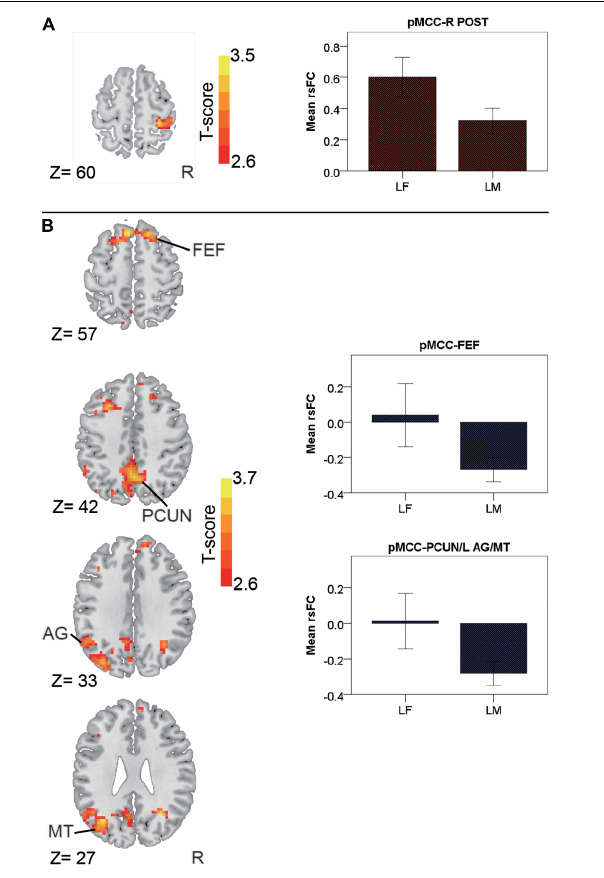
FIGURE 4 | Regions showing the gender differences in the late-adulthood stage detected by two-sample t -test (with a permutation test correction threshold of p < 0.05) in the pMCC(+) network (A) and the pMCC(-) network (B) , each with the corresponding mean strength between the seed and region for the males and females shown in the bar plot, error bars indicated two standard errors (pMCC, posterior midcingulate cortex; POST, postcentral gyrus; FEF, frontal eye field; PCUN, precuneus; AG, angular gyrus; MT, middle temporal visual area; L, left; R,